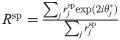
Spontaneous activity patterns.(A–C) Raster plot of spontaneous activity for networks with different degrees of specific connectivity. The similarity between spontaneous activity and patterns of activity evoked by oriented stimuli is quantified by a similarity index (SI). It is taken as the magnitude of the complex number Rsp=∑jrjspexp(2iθj*)∑jrjsp, where rjsp is the average firing rate of excitatory neuron j in bins of size 20 ms, and θj* is the input preferred orientation of the neuron. Other conventions are as in Fig 2. (D) Distribution of SI of spontaneous activity extracted from a simulation of duration 30 s for three networks shown in (A–C). (E) The angle of R
sp indicates the preferred orientation of the population activity in each time window. The distribution of this “spontaneous” tuning of population activity is plotted here for the three networks shown in (A–C). (F) The average SI of spontaneous activity, computed from distributions as in (D), is plotted for 11 networks ranging from completely random to highly feature-specific (black dots). To quantify the bias in the preferred orientation of the population activity in each network, the selectivity of the distributions of preferred orientations as in (E) are computed (Avg. bias, gray). It is computed as 1−Circular Variance of the distribution in (E).